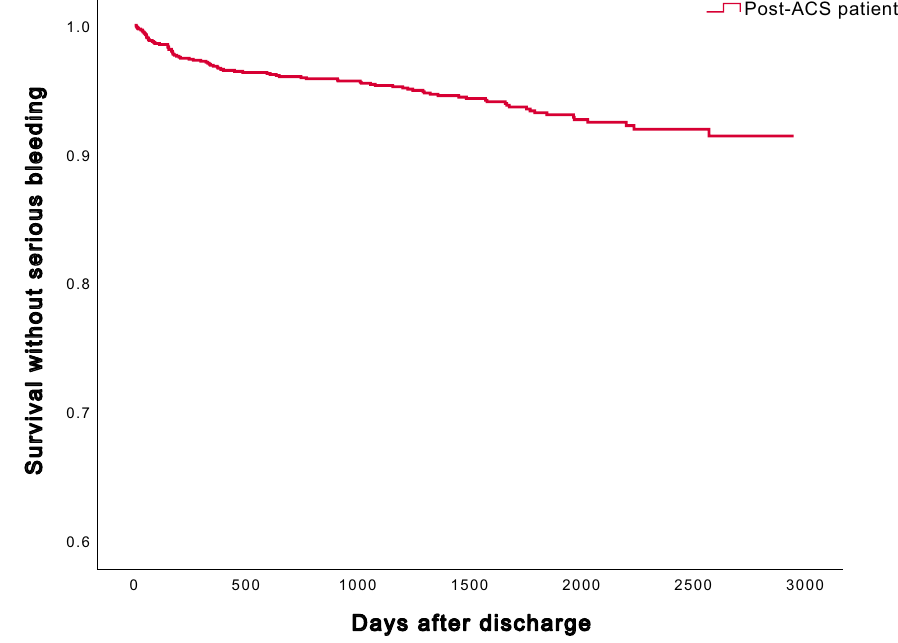
Figure 2. Cumulative incidences without serious bleedings during long-term follow-up.